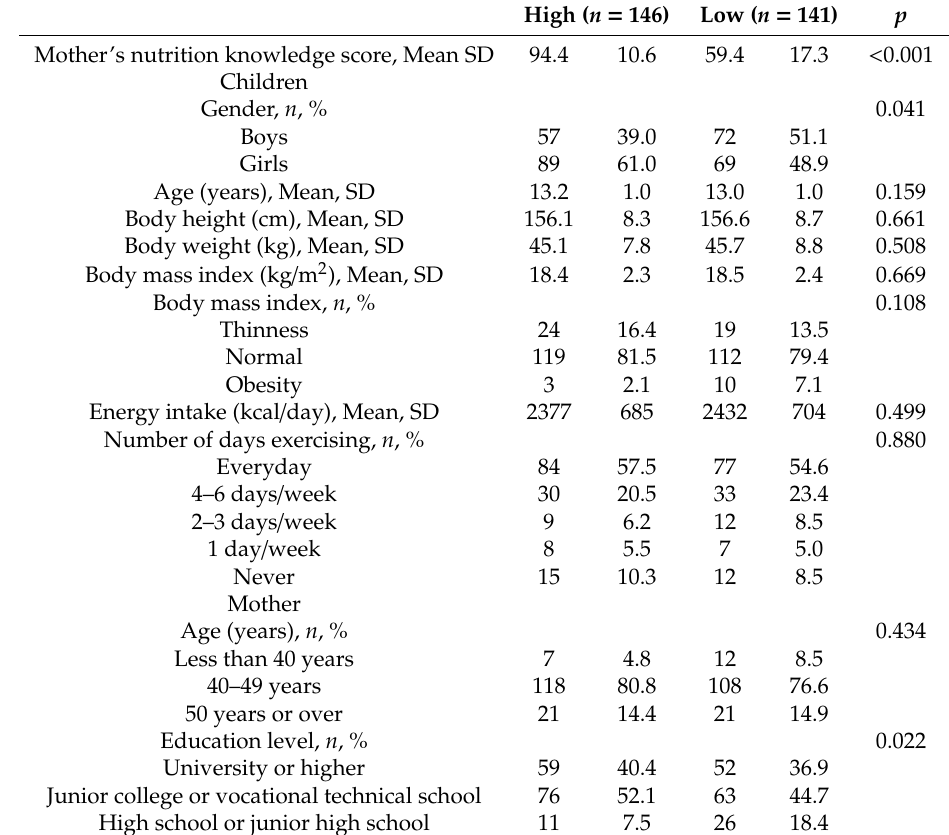
Table 1. Characteristics of study participants categorized into high and low groups by mother’s nutrition knowledge